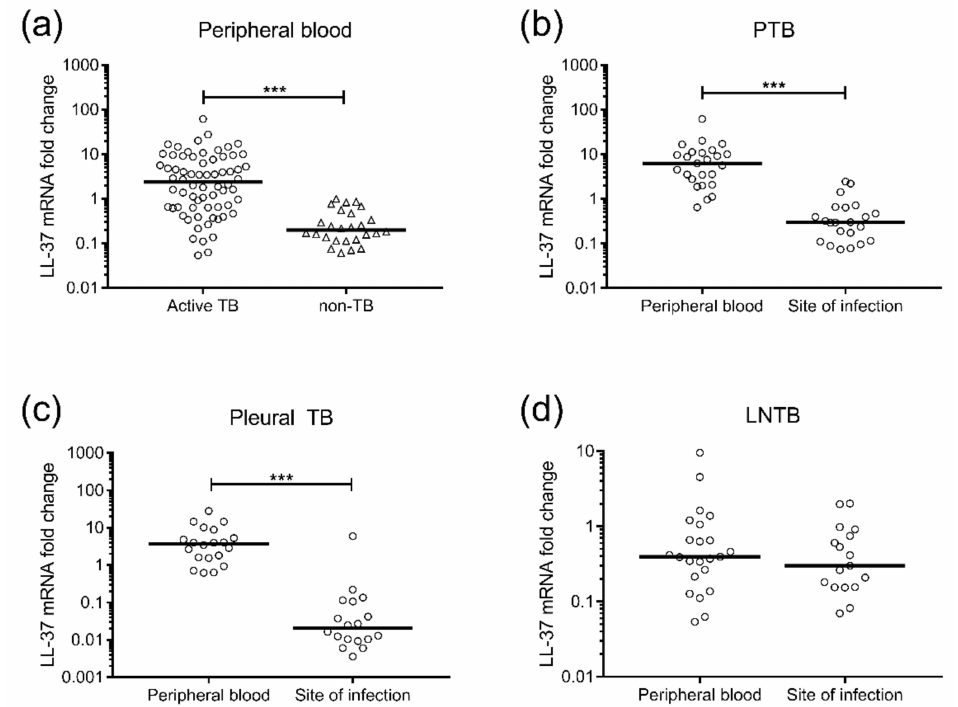
Figure 3. Peripheral and local mRNA expression of the antimicrobial peptide LL-37 in patients with active TB. Relative mRNA expression (median) of LL-37 in ( a ) peripheral blood (PBMCs) from active TB (PTB, pleural TB and LNTB) patients (circles) and non-TB controls (triangles), ( b ) in peripheral blood (PBMCs) compared to the site of infection (BAL cells) from patients with pulmonary TB (PTB), ( c ) in peripheral blood (PBMCs) compared to the site of infection (pleural fluid cells) from patients with pleural TB, and ( d ) in peripheral blood (PBMCs) compared to the site of infection (cells from lymph node tissue) from patients with lymph node TB (LNTB). Data are presented in box plots as a fold change LL-37 mRNA in TB patients normalized to non-TB controls. *** p <